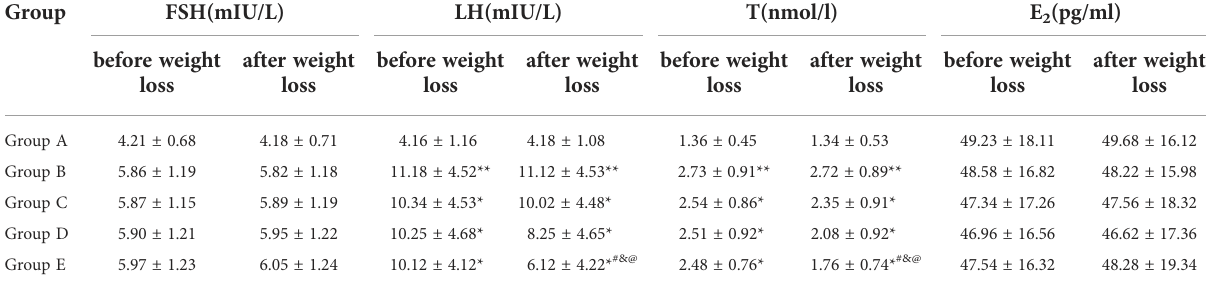
TABLE 4 Basic reproductive hormones.